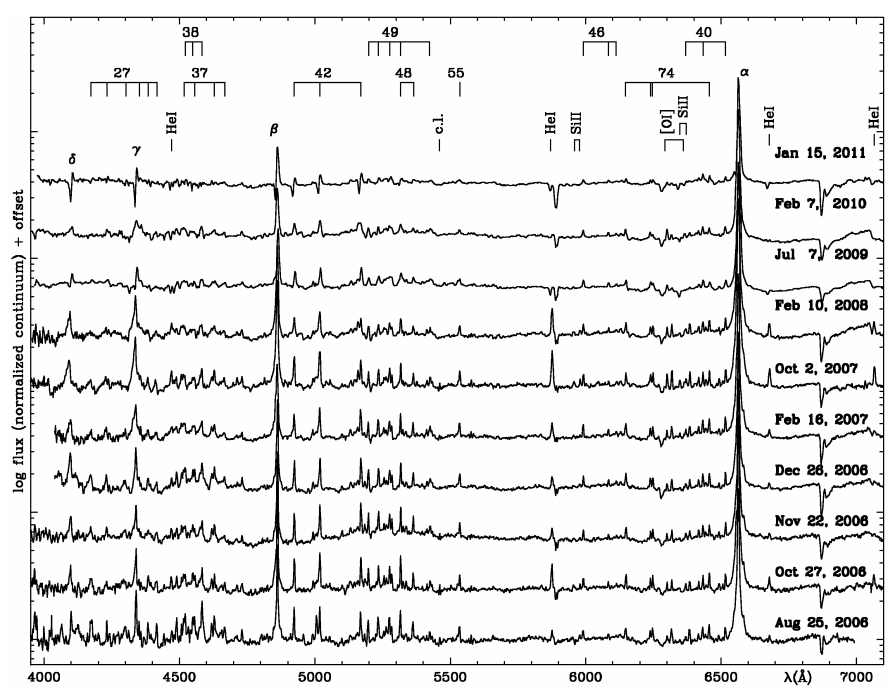
Fig. 3. Spectroscopic monitoring in low resolution of BF Cyg since the onset of the outburst. Spectra are continuum normalized and plotted on a logarithm (cid:13)ux scale. Principal emission lines are